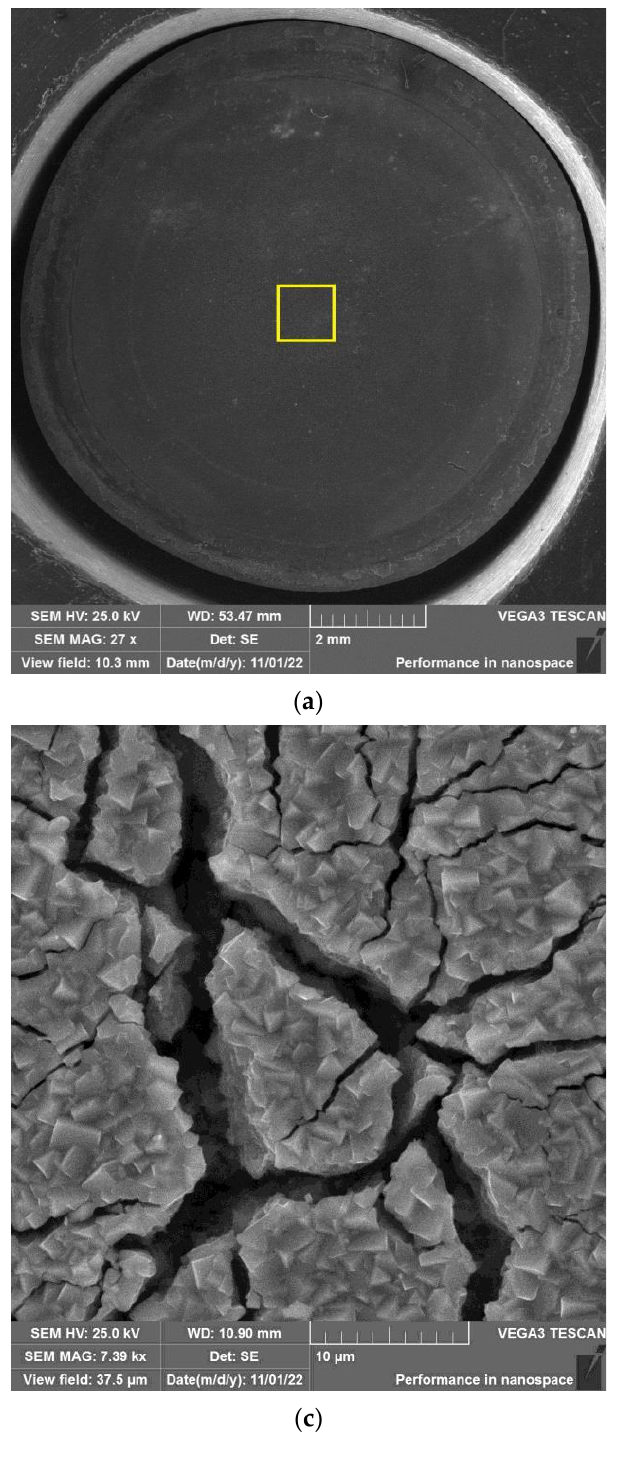
Figure 18. Surface of disk specimen № 9 (T irr = 550 °C, Table 4) at different magnifications after autoclave SCC tests with a load value of 801 N and additional loading up to 6102 N.